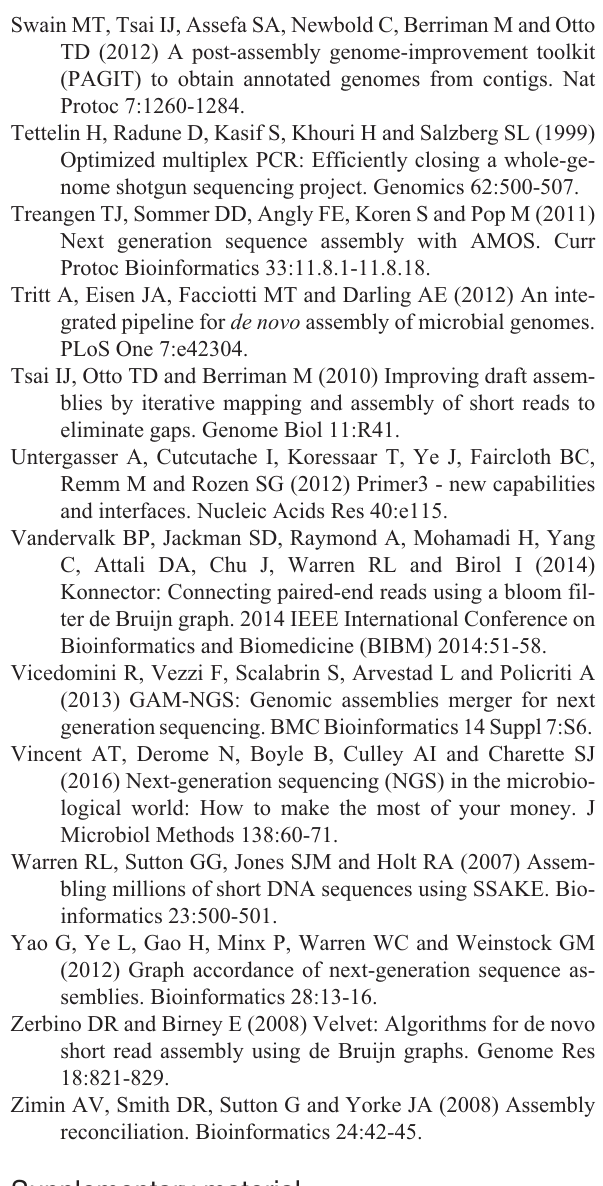
Table S1 - Examples of sequenced microbial ge- nomes for which the tools discussed in the present review were